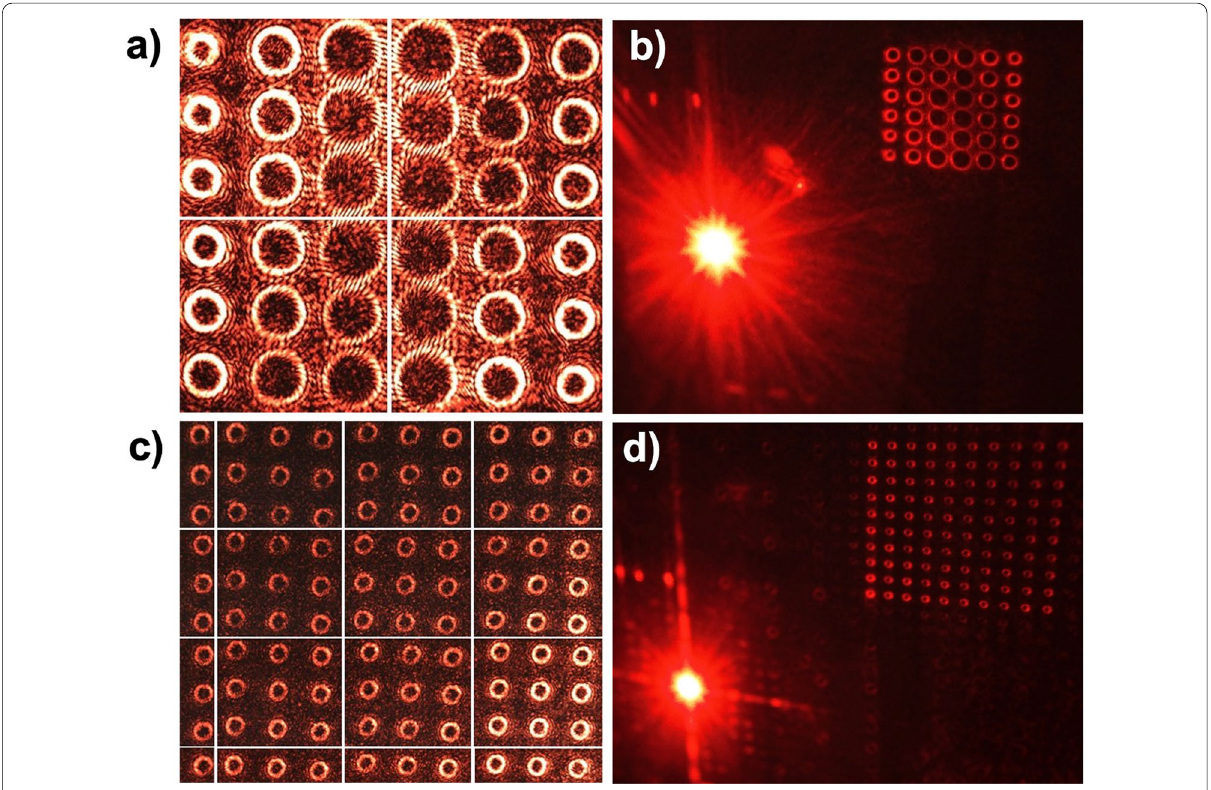
Fig. 12 Reconstructions captured from 1st order diffracted beams of multiplexed holograms. A 6 × 6 optical vortex array consisting of + topological charges l = − 6, − 12, − 24 a captured directly on a CCD sensor, b captured from a screen using a camera showing the 0th order and 1st diffracted beams. A 10 × 10 optical vortex array consisting of topological charges l = − 10 c captured directly on a CCD sensor, d captured + from a screen using a camera, showing the 0th order and 1st diffracted beams.(The white horizontal and vertical lines in the CCD images ( a , c ) are + due to a tiled capture procedure adapted due to the CCD sensor area being smaller than the reconstructed vortex array